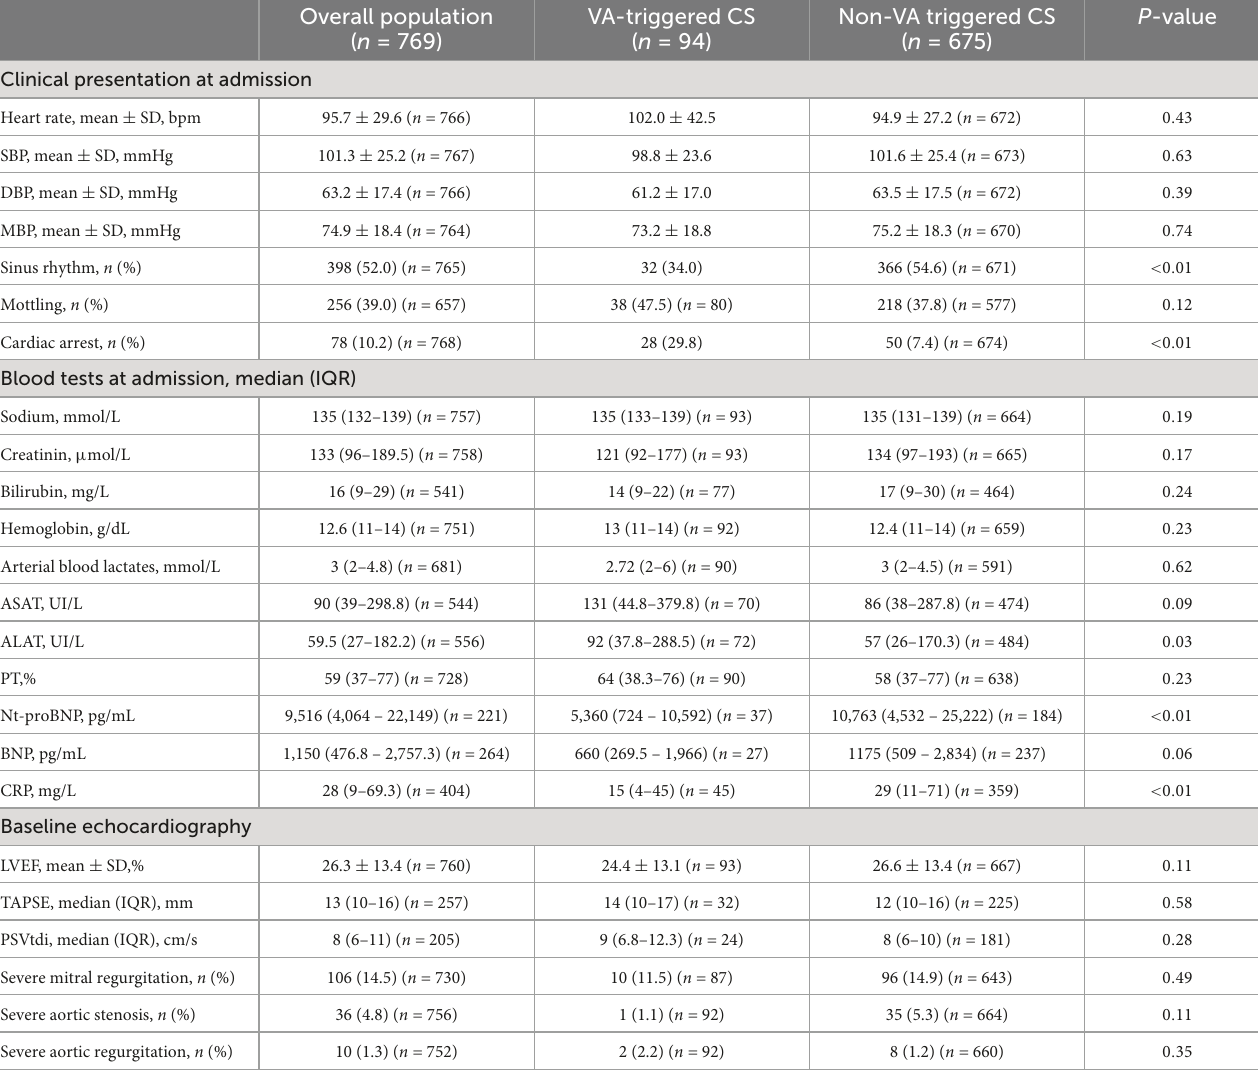
TABLE 2 Clinical, echocardiographic, and biological parameters at admission according to cardiogenic shock triggers (VA vs. non-VA).